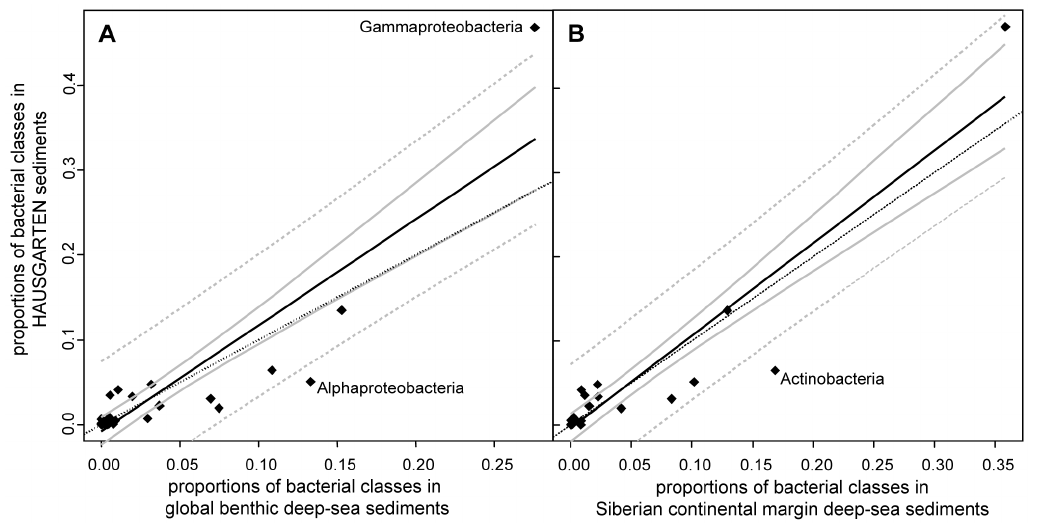
Figure 2. Comparison of bacterial classes in sediments from HAUSGARTEN with other datasets. A: Globally distributed sediments; B: sediments from the Siberian continental margin. The solid lines indicate the best fit using linear regression; solid grey lines indicate 95% confidence intervals; dotted grey lines indicate predicted intervals at a 95% confidence level; dotted black lines indicate the case where equal proportions were found in the datasets being compared (y=x).